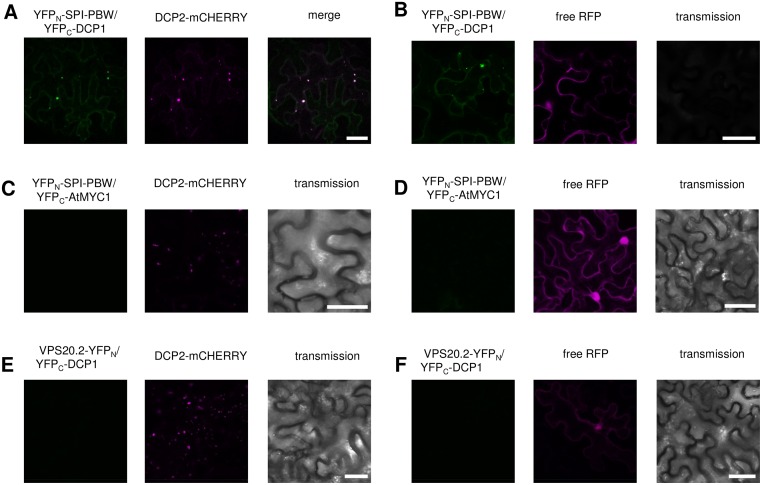
SPI and DCP1 interact at P-bodies in BiFC assays.Fusion proteins are expressed under the control of the 35S promoter. (A) Interaction of YFPN-SPI and YFPC-DCP1 (left) in transiently transformed N. benthamiana leaves 72 h post-transfection at DCP2-mCHERRY labeled P-bodies (middle). Right pictures show the overlay of the left (green) and middle (magenta) pictures. (B) Interaction of YFPN-SPI and YFPC-DCP1 in cytoplasmic dots (left) in N. benthamiana leaves coexpressing free RFP as transformation control (middle). Right pictures show the corresponding transmission picture. (C–F) Representative images of BiFC negative controls. No YFP signal in leaf epidermis cells coexpressing YFPN-SPI-PBW and YFPC-AtMYC1 in combination with DCP2-mCHERRY (C) and free RFP (D). No YFP signal in leaf epidermis cells coexpressing YFPC-DCP1 and VPS25-YFPN in combination with DCP2-mCHERRY (E) and free RFP (F). Scale bar: 50 μm.